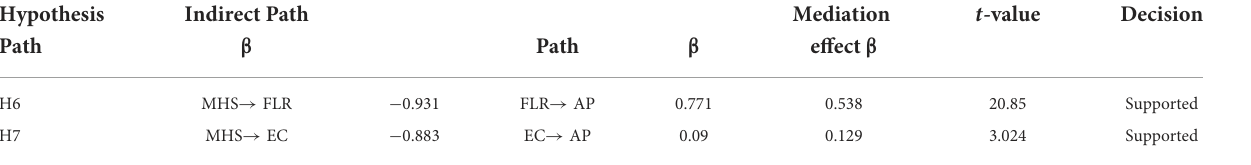
TABLE 6 Direct and indirect path effect coefficients (mediation